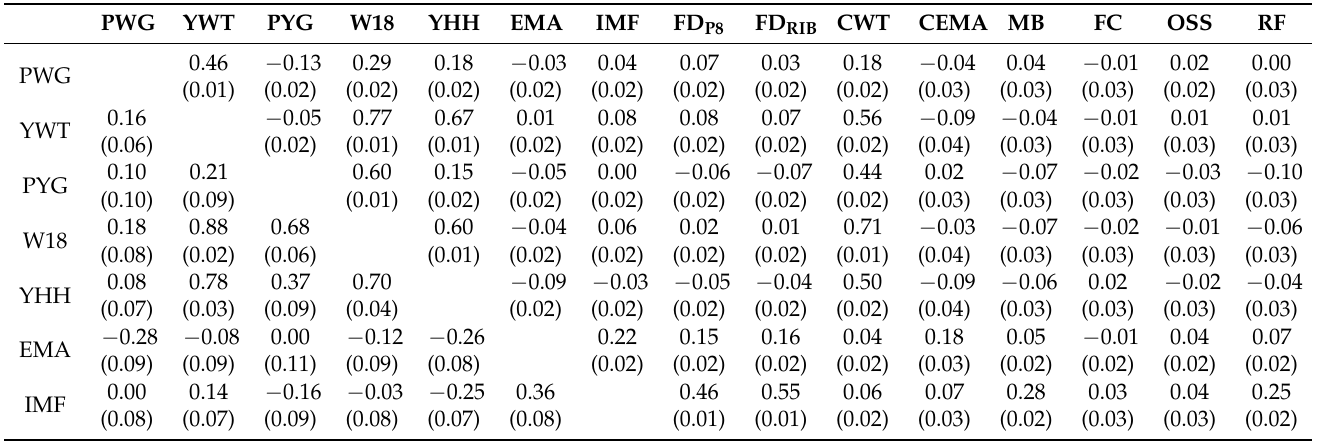
Table 5. Genetic (SE; below diagonal) and phenotypic correlations (SE; above diagonal) among finishing traits in New Zealand beef